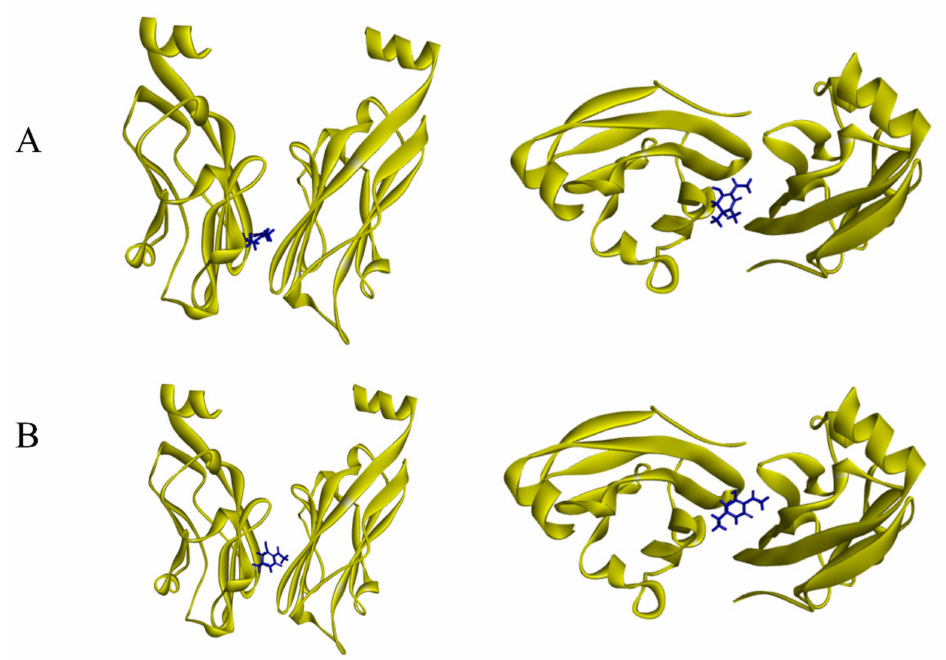
Figure 9. Results of docking simulation from different angles. ( A ) Binding modes of 2 at the PD-L1 dimer interface. ( B ) Binding modes of 3 at the PD-L1 dimer